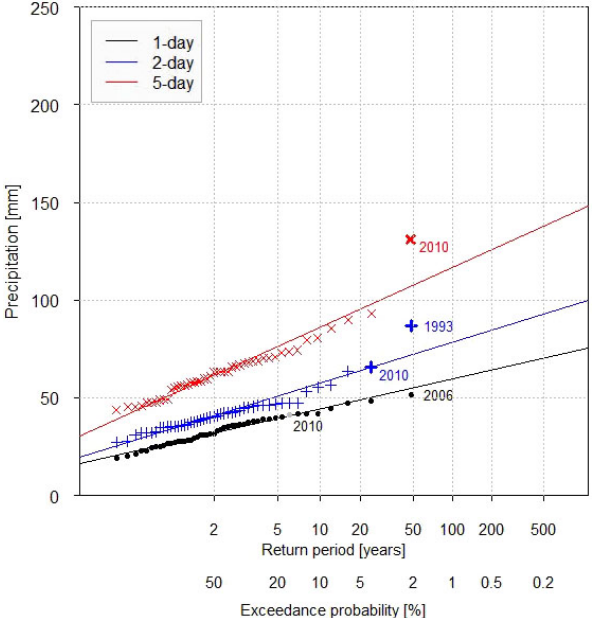
Figure 9. Extreme-value distribution of 1-day (black crosses), 2- day (blue crosses) and 5-day (red dots) precipitation sums of Granja Kcayra near the city of Cusco (data from SENAMHI), arranged by their respective ranking. The reference period is 1965–2011. The x axis is scaled with the Gumbel extreme-value distribution.